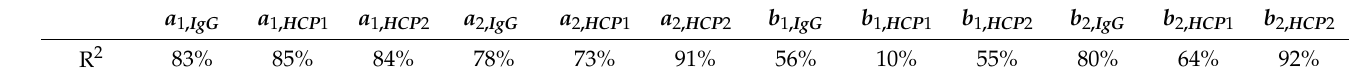
Table 2. Coefficient of determination of the phase equilibrium parameters from the test set.